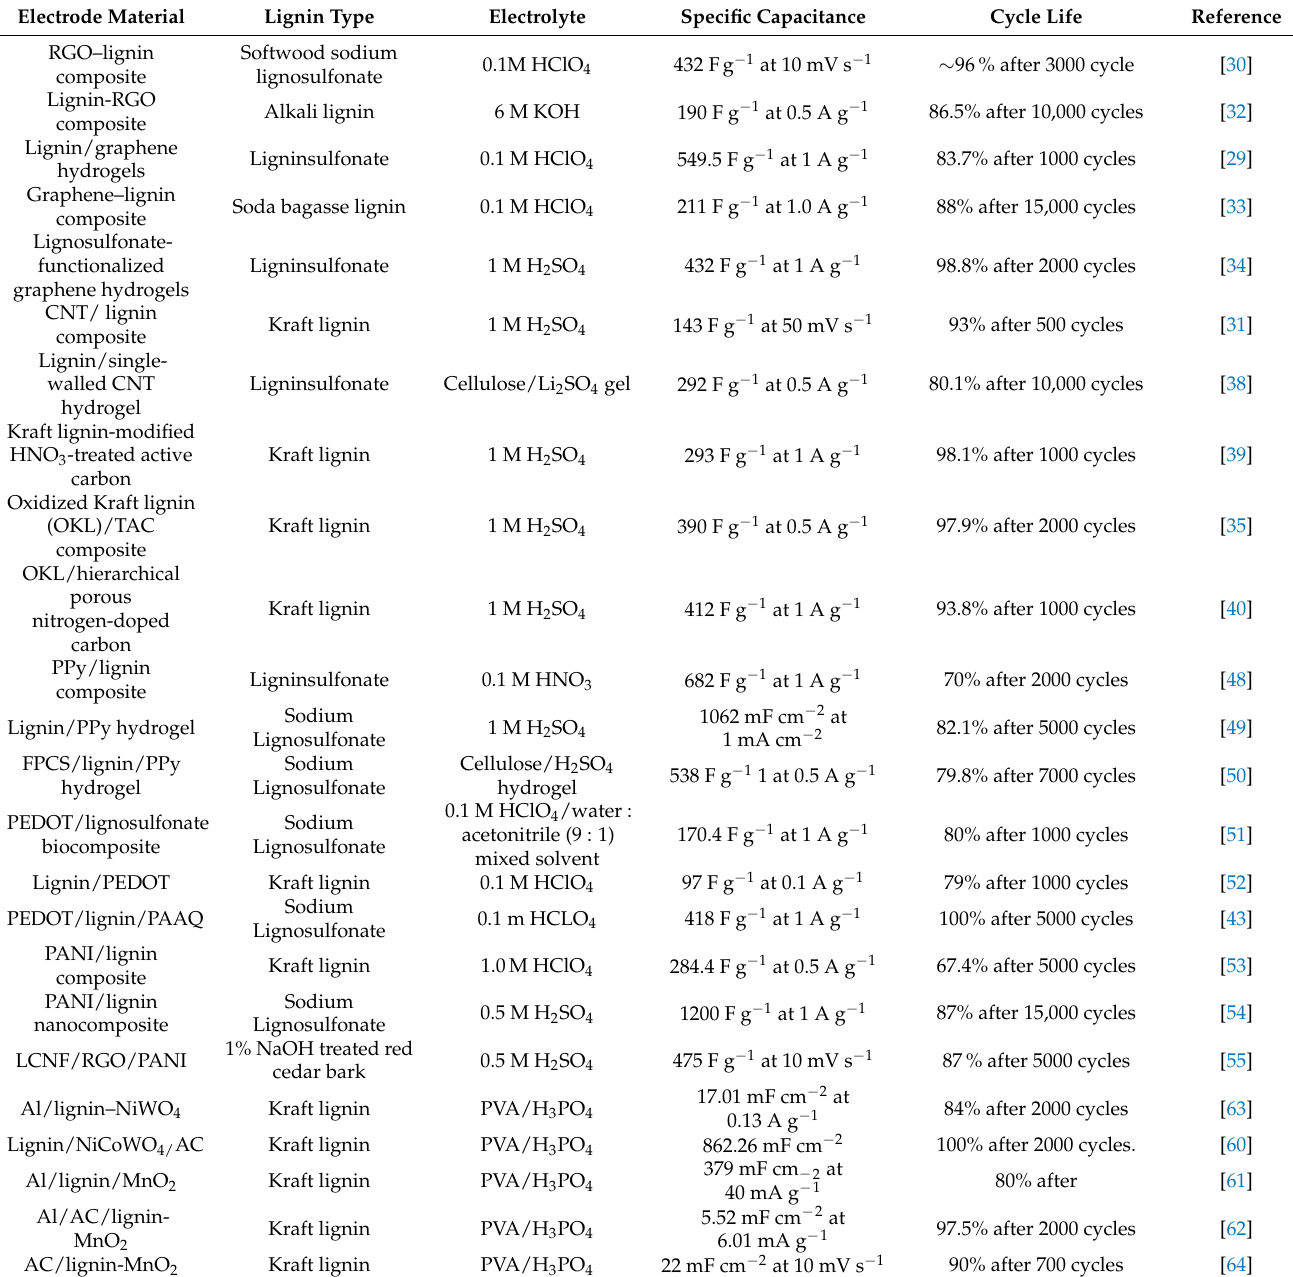
Table 1. Overview of lignin-based electrodes for